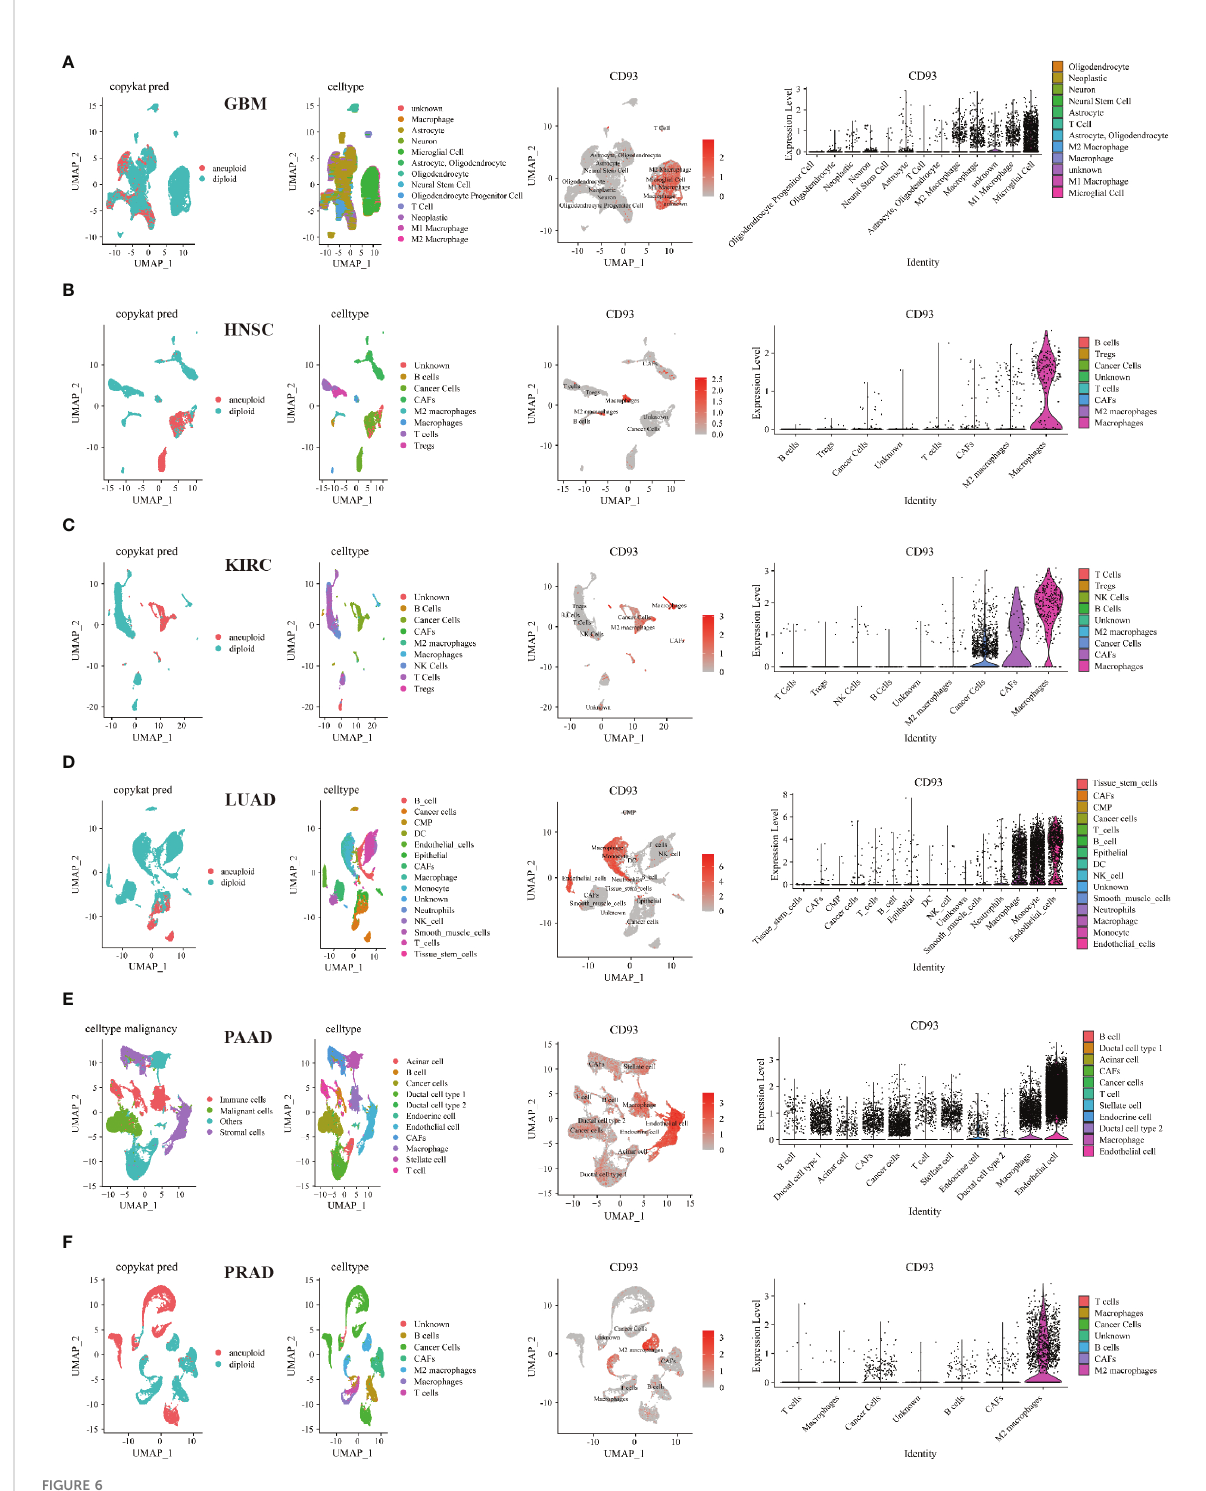
FIGURE 6 Single-cell sequencing analyzing the co-expression of CD93 on tumor and stromal cells in the TME. Co-expression of CD93 on tumor and stromal cells in GBM (A) , HNSC (B) , KIRC (C) , LUAD (D) , PAAD (E) , and PRAD (F)